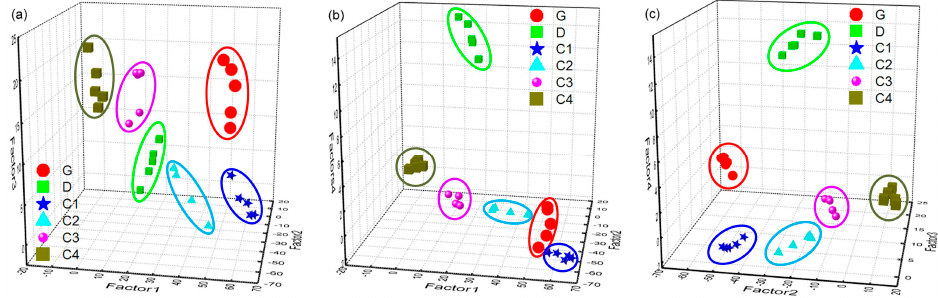
Figure 10. PARAFAC score scatter plots of six oil samples on four factors, ( a ) is the score scatter plot on factor1, factor2 and factor3, ( b ) is the score scatter plot on factor1, factor2 and factor4, ( c ) is the score scatter plot on factor2, factor3 and factor4.